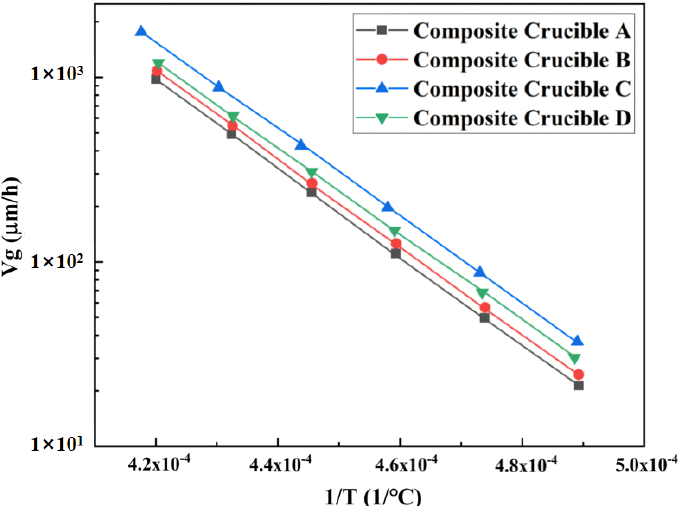
Figure 6. Comparison of the growth rates of the AlN crystals grown in four composite crucibles.